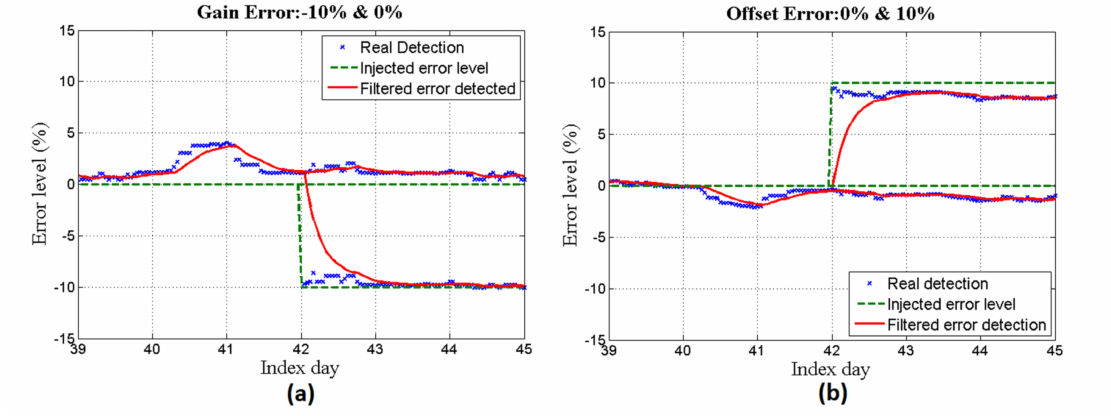
Figure 10. ( a ) 0 % and − 10% gain errors and ( b ) 0% and 10% offset errors during the days after